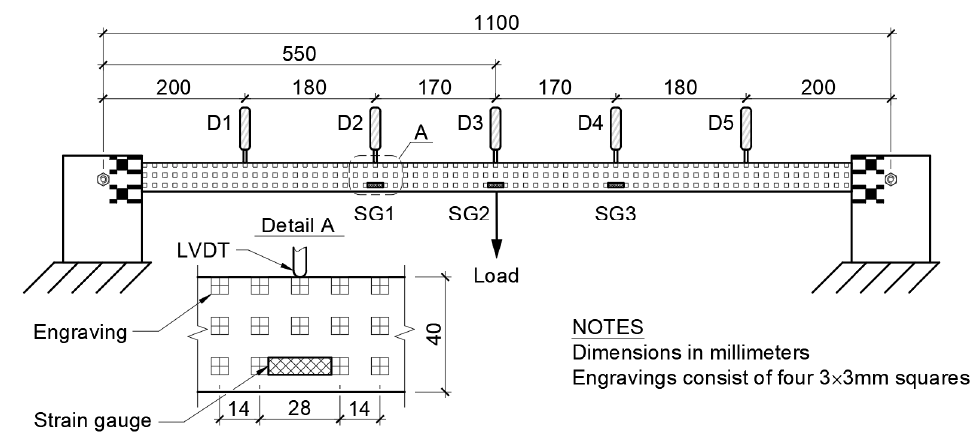
Figure 5. A sketch of the test beam with its principal dimensions and sensor locations.